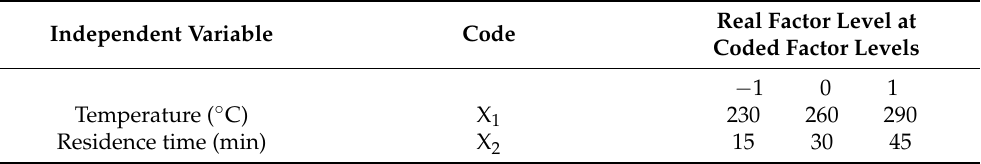
Table 1. Code levels utilized in the central composite design and real factor levels corresponding to coded factor levels for torrefaction